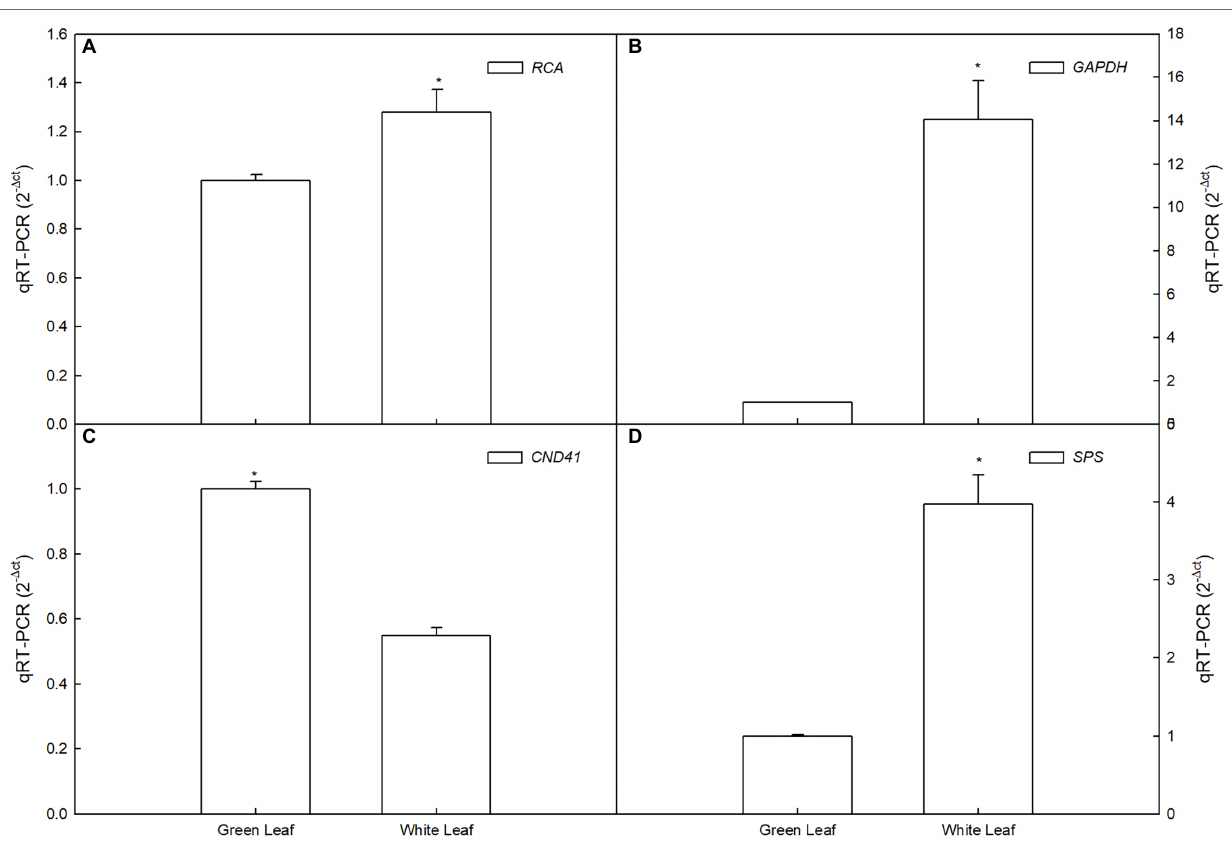
FIGURE 8 | Expression analyses of RCA, GAPDH, CND41, and